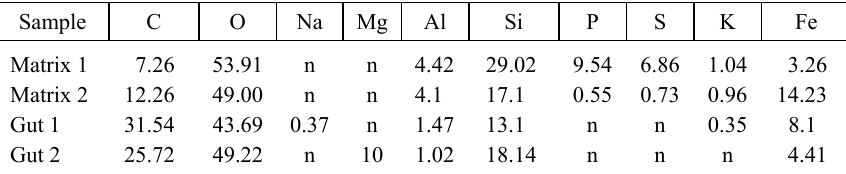
Table 3. Results of the energy dispersive X-ray (EDX) analyses performed on the gut and the surrounding sediment. The composition is expressed in weight percentage (wt%). Some elements were not detectable and/or the estimated proportions was below the equipment’s lower limit of reliability (referred as